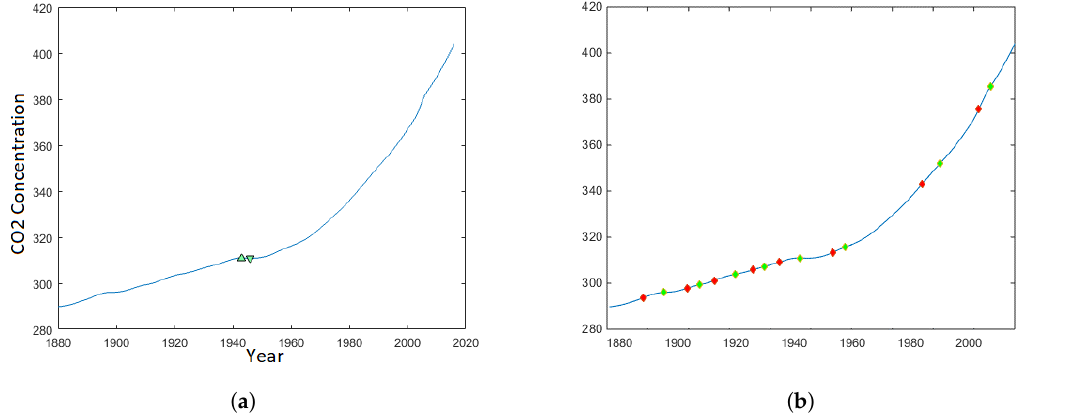
Figure 5. CO 2 concentration: ( a ) Detected maximum (upward green arrow) and minimum (downward green arrow) in CO 2 concentration (Y axis) between 1880 and 2017 (X axis); ( b ) Identified inflection points in CO 2 concentration (Y axis) between 1880 and 2017 (X axis). Positive inflection point (red diamond); negative inflection point (green